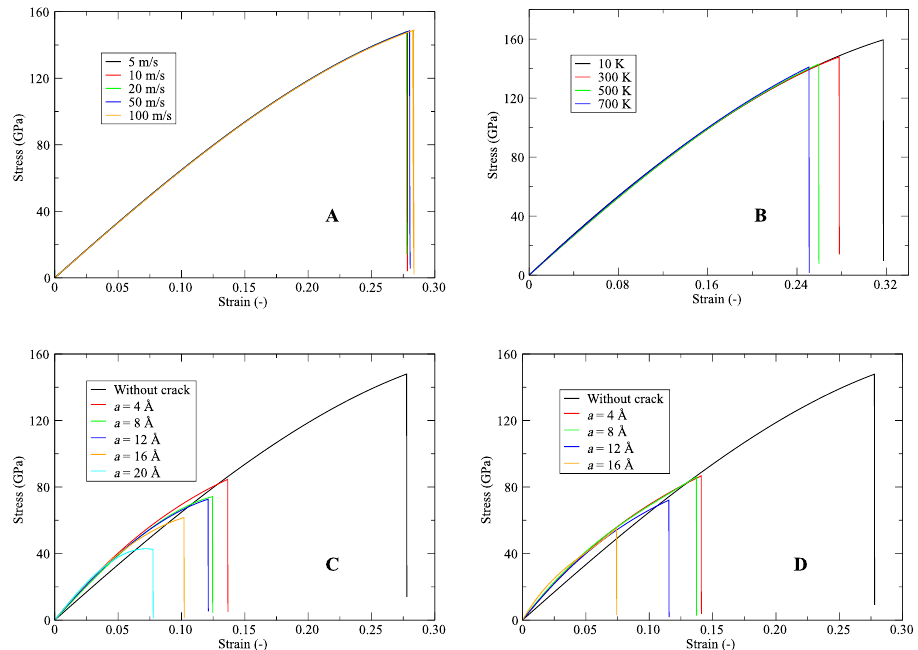
Figure 6. Stress–strain behaviour for ( A ) a range of pulling speed, and ( B ) change in temperature of the (20,20) SWCNT. Moreover, stress–strain trajectories for various crack depths of ( C ) SWCNT and ( D )